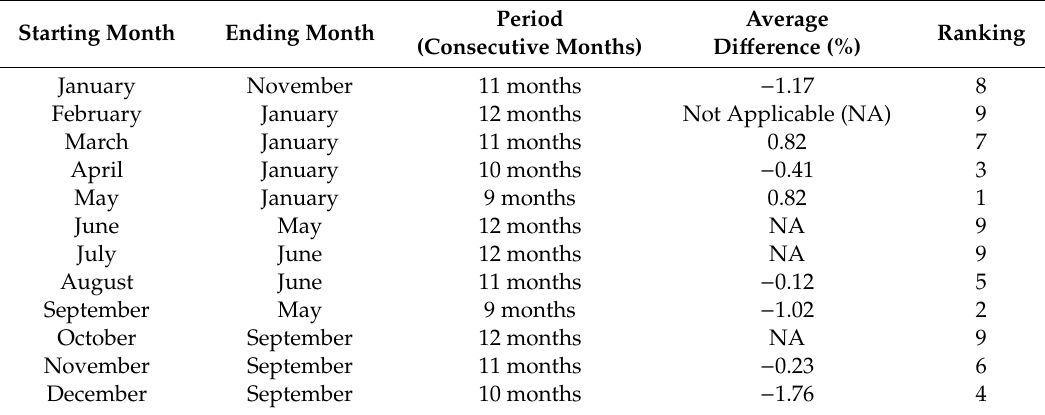
Table 5. Results from the ranking analysis for the heating slope coe ffi cient ( HS